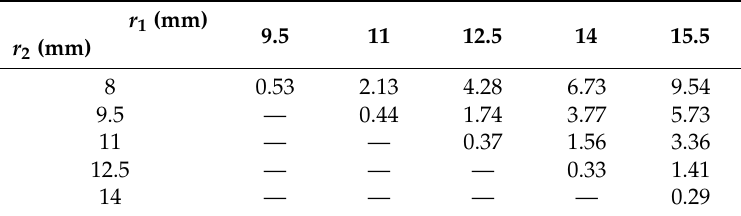
Table 2. U AC_rms (mV) obtained by setting different sensor